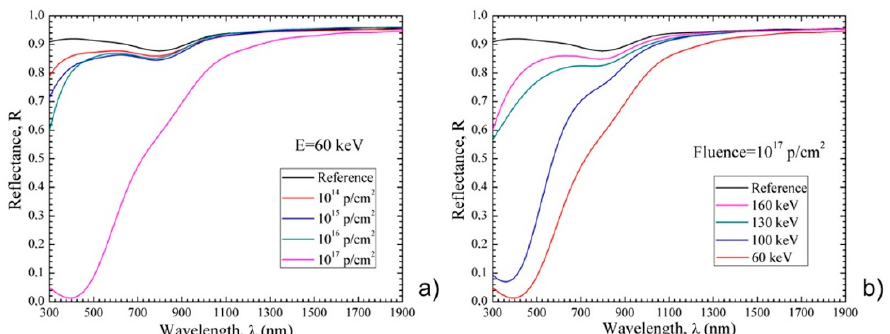
Figure 3. E ff ect of protons on mirror reflectivity. ( a ) Evolution of the UV-VIS reflectance of a Figure 3. Effect of protons on mirror reflectivity. a ) Evolution of the UV ‐ VIS reflectance of a SiO 2 ‐ SiO 2 -protected Al mirror irradiated with protons at 60 keV with di ff erent fluences (data retrieved protected Al mirror irradiated with protons at 60 keV with different fluences (data retrieved from from [110]). ( b ) Evolution of the UV-VIS reflectance of SiO 2 -protected Al mirror irradiated with protons [110]). b ) Evolution of the UV ‐ VIS reflectance of SiO 2 ‐ protected Al mirror irradiated with protons at at di ff erent energies and keeping a fluence of 1 · 10 17 p / cm 2 (data retrieved from di ff erent energies and keeping a fl uence of 1 · 10 17 p/cm 2 (data retrieved from [110]).